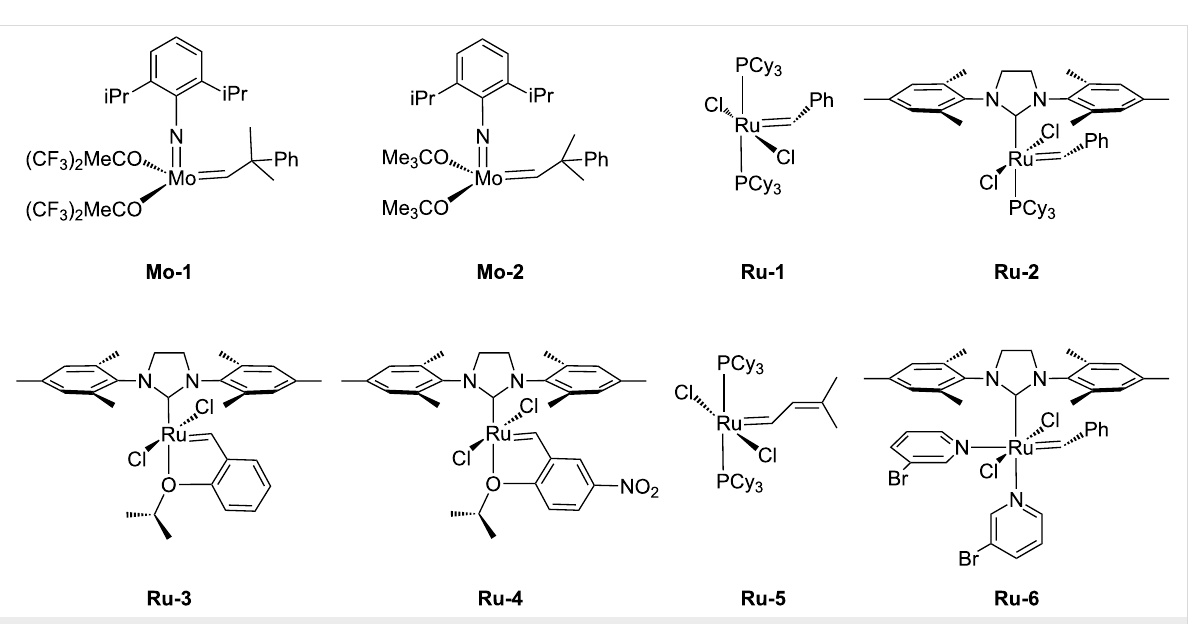
Figure 3: Olefin metathesis catalysts used in transformations of silsesquioxanes.